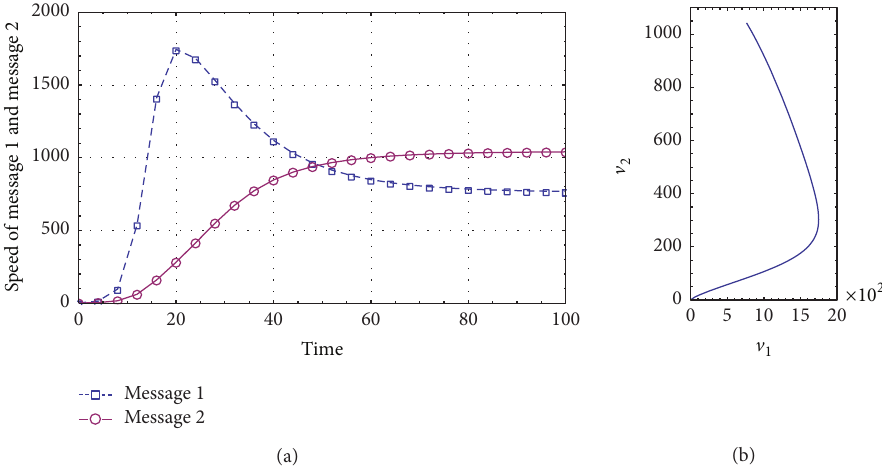
Figure 8: (a) V 1 and V 2 as a function of 𝑡 , with V 1 (0) = 2 , V 2 (0) = 1 , 𝑉 1 = 3000 , 𝛼 = 80 , 𝜎 8(𝑎) 12 = 0.6 , 𝜇 1 = 0.7 , 𝜆 1 = 0.2 , 𝑉 2 = 1800 , 𝛽 = 20 , 𝜎 8(𝑎) = 0.8 , 𝜇 = 0.5 , and 𝜆 = 0.15 . (b) The development trend of relationship between message 1 and message 2. 2 2 21